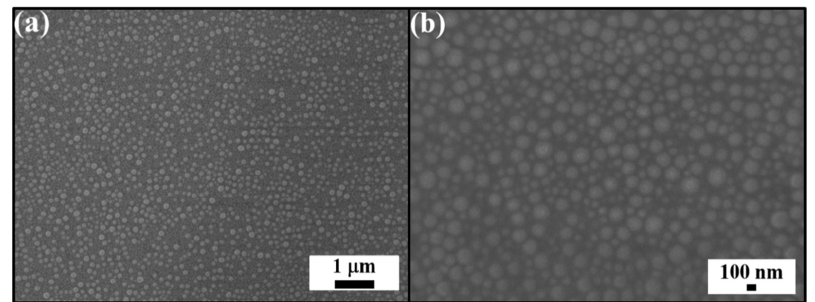
Figure 2. ( a ) Top-view SEM image of a randomly arranged 80/130/180 nm silica colloid-coated PET substrate. ( b ) Magnified SEM image of ( a ).